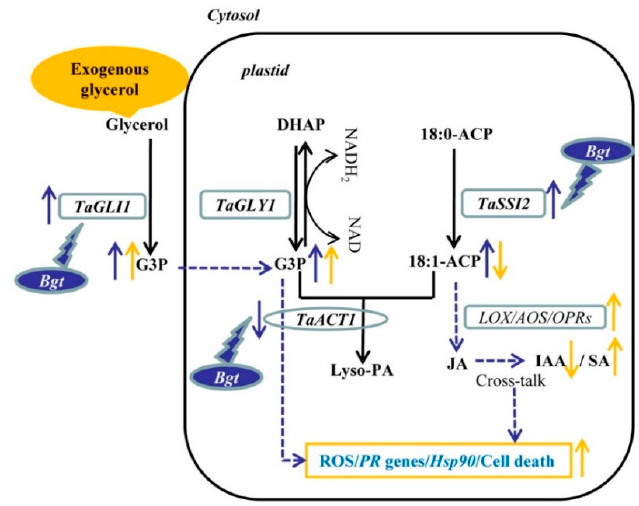
Figure 8. The glycerol-induced resistance pathway. Upon Bgt infection, the TaGLI1 and TaSSI2 were induced, and TaACT1 was reduced, which might contribute to G3P and OA18:1 accumulation. G3P accumulation might be an active defense process; OA18:1 accumulation might be not good for plant resistance. Exogenous application of glycerol increased the G3P levels and decreased the level of OA18:1. Glycerol induced some genes involved in JA synthesis (e.g., LOX , AOS, and OPRs ), then induced the JA level. Glycerol reduced IAA and induced SA levels with cross-talk of plant hormones. Glycerol induced ROS accumulation, PR and Hsp90 genes expression, and cell death, then contributed resistance to Bgt in